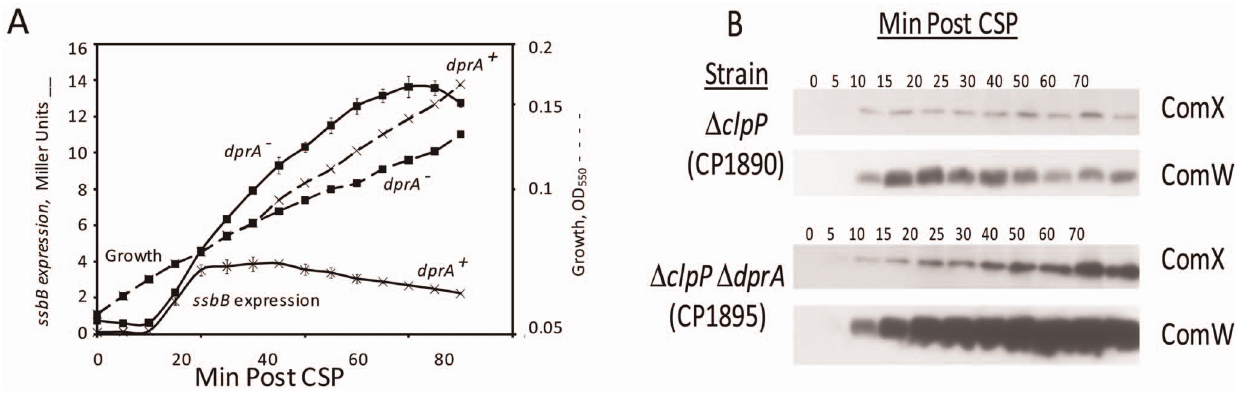
Figure 5. Prolonged accumulation of ComX and ComW in a D clpPdprA 2 mutant but not in a D clpP mutant. A. Late gene expression in strains CP1890 (x, dprA + D clpP ) and CP1895 ( % , D dprA D clpP ) was monitored by measuring b -galactosidase activity (Miller units) (–) in a culture treated with CSP. The lacZ reporter was in a transcriptional fusion to the ssbB promoter. Points are averages of three samples and error bars represent their standard deviation. –, growth of the cultures. B. Western blot analysis of samples taken in parallel to samples for late gene expression run in a separate gel, transferred to a separate membrane for each strain and probed with antisera specific to both ComX and ComW using the ECL substrate and imaged on a separate film for each strain. Each lane represents a cell lysate from 0.6 ml of culture.